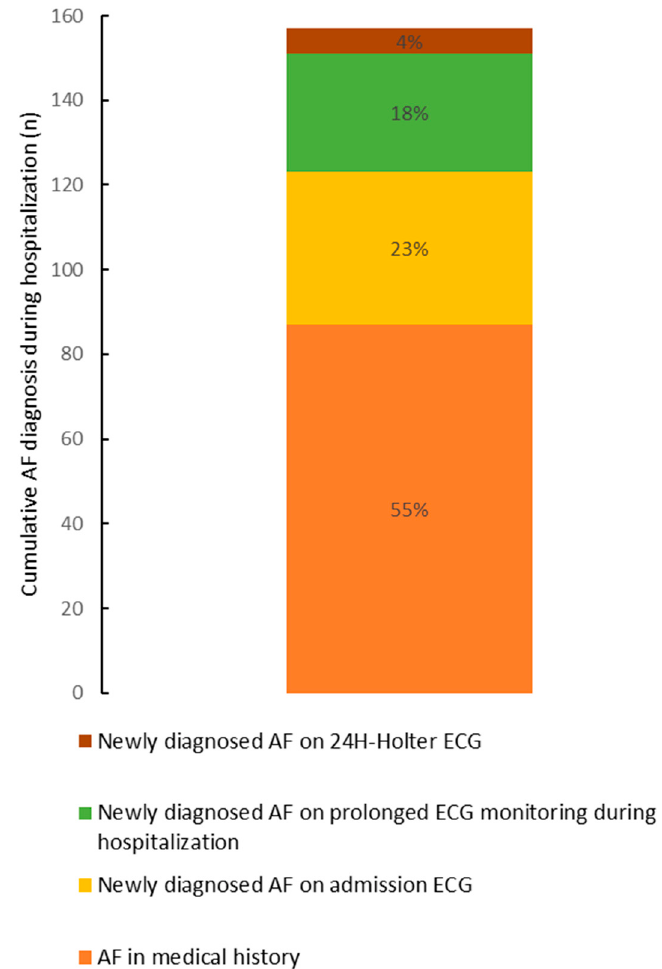
Figure 2. AF diagnosis modalities for KIDAF. ESUS patients with CPAF detected by ICM presented less severe strokes than patients with KIDAF, as illustrated by the significantly lower initial NIHSS score in this group (3.00 IQR (1.00–8.25) vs. 14.50 IQR (6.00–21.00)) (Figure 3). A lower prevalence of symp- tomatic arterial occlusions was also observed, as well as a lower proportion of large vessel occlusions, which was apprehended by the rate of mechanical thrombectomy performed (5/38 (13.16%) vs. 56/157 (35.67%)). Patients with CPAF detected by ICM were significantly younger than patients with KIDAF. Regarding cardiologic features, LAD occurrence did not differ between the two groups; however, left ventricular dysfunction was more frequent in the KIDAF group (39/122 (31.97%) vs. 4/38 (10.53%)). NT pro-BNP levels were significantly higher in the KIDAF group compared with the CPAF detected by ICM group. The thromboembolic risk of AF apprehended by the CHA2D2S-VASc score was signif- icantly higher in the KIDAF group. Among the predictive scores of AF occurrence, only AS5F was significantly higher in